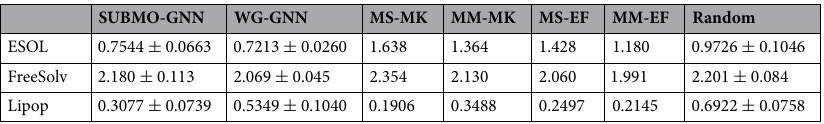
Table 3. WDUD values in the out-of-domain setting. For SubMo-GNN, WG-GNN, and Random, means and standard deviations over five trials are shown.